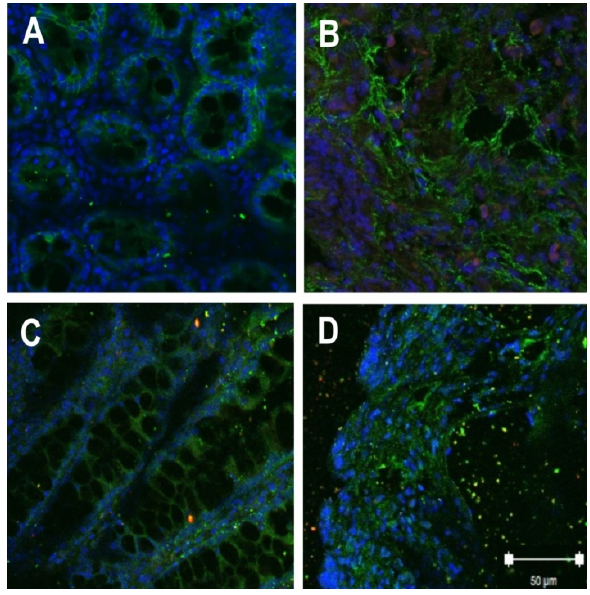
Figure 2. Localization of claudin-3 ( A —control, B —tumor) and claudin-4 ( C —control, D —tumor) in rat colon by immunofluorescence confocal microscopy (green); bar: 50 μ m.